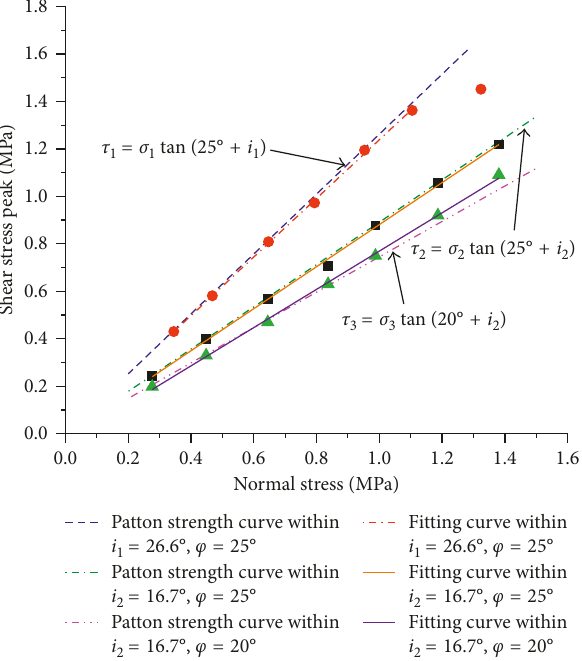
Figure 7: Shearing strength curve of the infilled joint with different undulating angles and friction